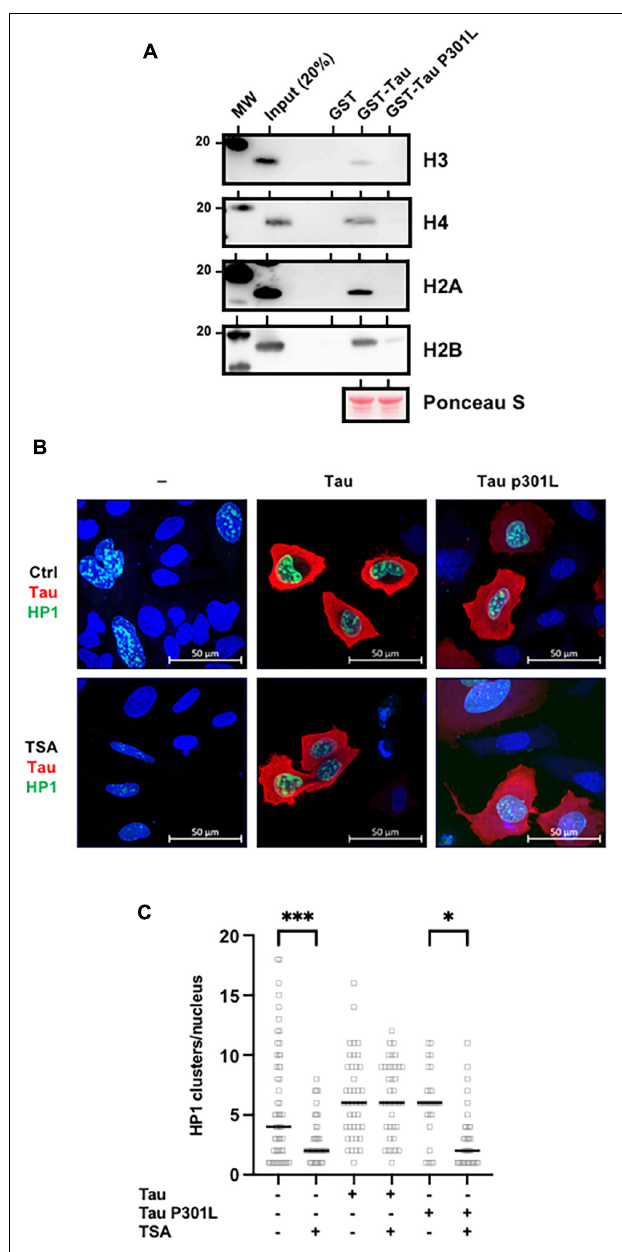
FIGURE 6 | Frontotemporal lobar degeneration Tau mutations disrupt its interaction with histones. (A) P301L mutation abolished Tau/histone interaction. GST-pulldown experiments were carried out using GST (1 µ g), GST-Tau4R (1 µ g) or GST-P301L (1 µ g), and purified core histones (1 µ g). Complexes were precipitated with Sepharose-glutathione beads, resolved by 12% SDS-PAGE and visualized by immunoblot analysis with antibodies against H3, H4, H2A, and H2B. GST-Tau and GST-TauP301L loading was controlled by Ponceau red staining. (B) Single confocal sections of Hela cells transfected with GFP-HP1 β , with or without Tau4R or TauP301L, and treated 24 h later with the TSA (300 nM) for 24 h. Tau C-terminus antibodies and GFP fluorescence were used to visualize total Tau protein and HP1 β respectively. Representative images are shown. (C) Quantification of HP1 β clusters per nuclei visualized as described previously and realized on three independent experiments. Data are mean ± SD, ∗ P < 0.05, ∗∗∗ P <